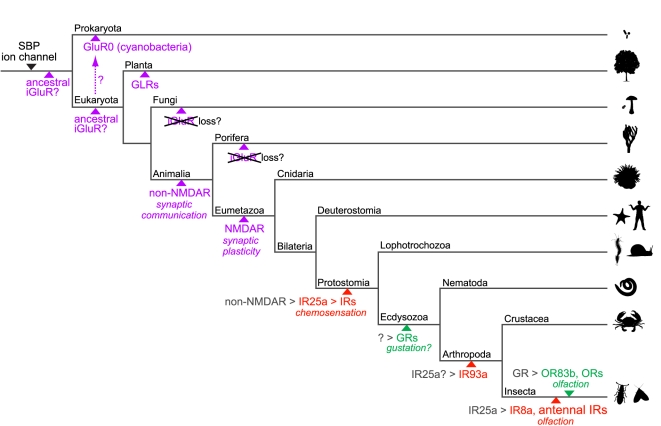
A model for the evolution of iGluRs and IRs.Schematic phylogenetic tree highlighting the branches along which specific gene families or genes appeared with their putative functions, inferred from their presence or absence in sequenced genomes of extant species (see Figure 1). Solute binding proteins (SBPs, which exhibit the same protein fold as the iGluR/IR amino terminal domain and ligand-binding domain) and ion channels were likely present in primitive life forms as related protein domains exist in Eukaryota, Bacteria and Archaea [94]. iGluRs are shown in purple, IRs in red and insect GRs and ORs in green. Various speculative models for the origins of iGluRs are shown. Putative genetic ancestors from which IRs, GRs and ORs derived are shown in grey followed by a “>” symbol. The resolution of the phylogeny is necessarily biased towards invertebrate lineages and branch lengths contain no temporal information.